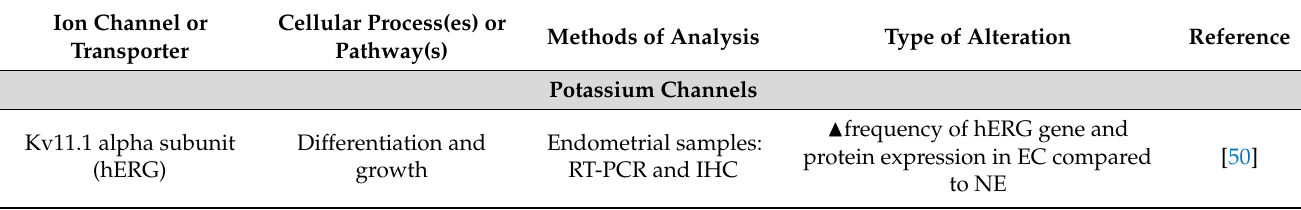
Table 1. Expression of ICTs in endometrial